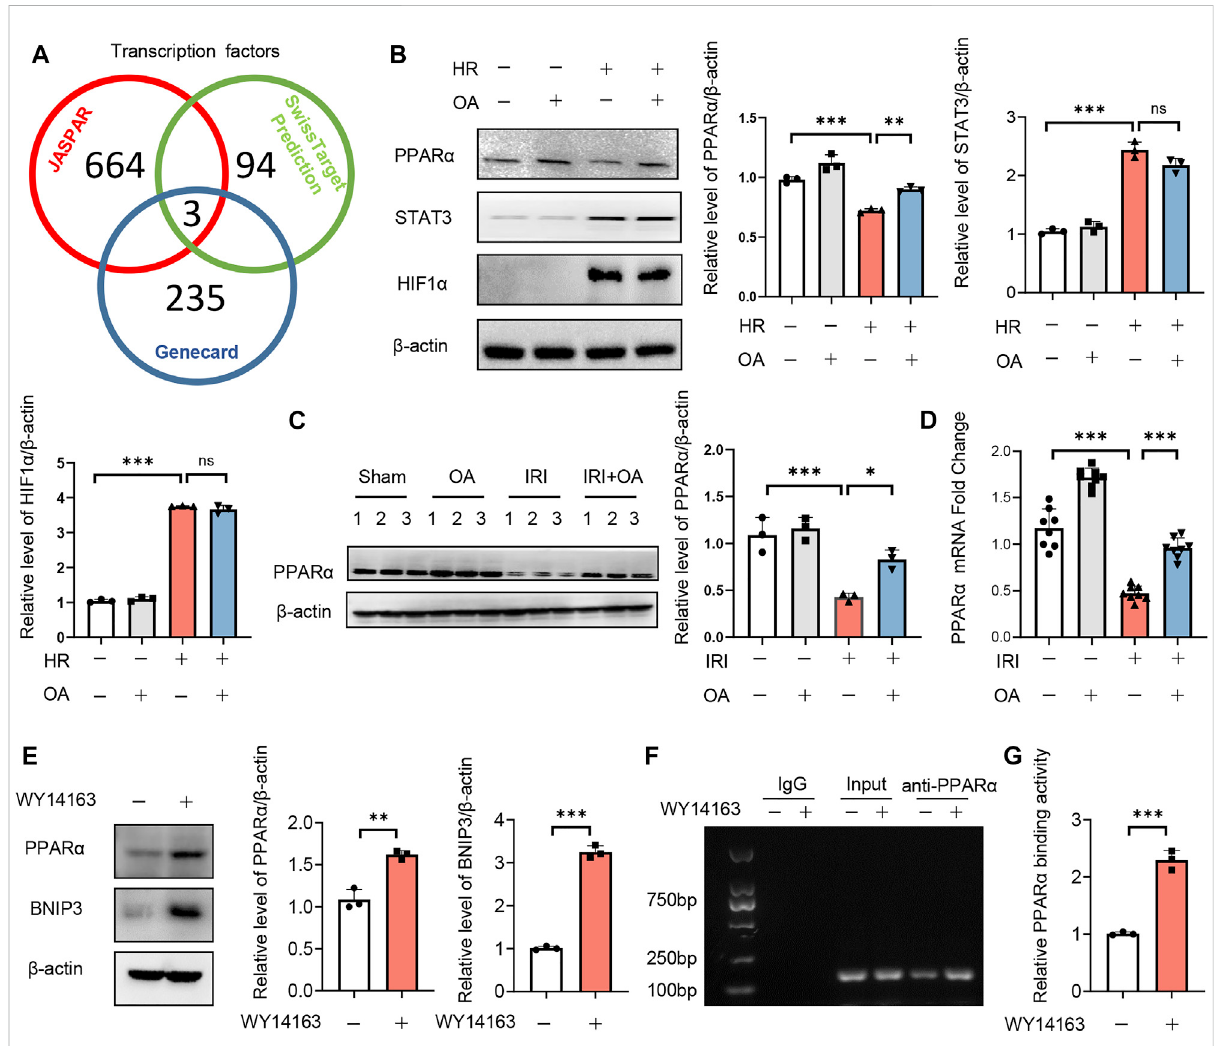
FIGURE 5 Transcription factor PPAR α induces BNIP3 expression via directly binding to its promoter region. (A) JASPAR, Genecard and SwissTarget (network pharmacology analysis) were employed to predict the upstream transcription factors of BNIP3, and three potential transcription factors were obtained, including PPAR α , STAT3 and HIF-1 α . (B) Expression of PPAR α , STAT3, and HIF-1 α in HK-2 cells incubated with control or OA after HR treatment ( n = 3). (C , D) Expression of PPAR α in kidney tissue from sham and AKI mice treated with control or OA ( n = 3 – 8). (E) Expressions